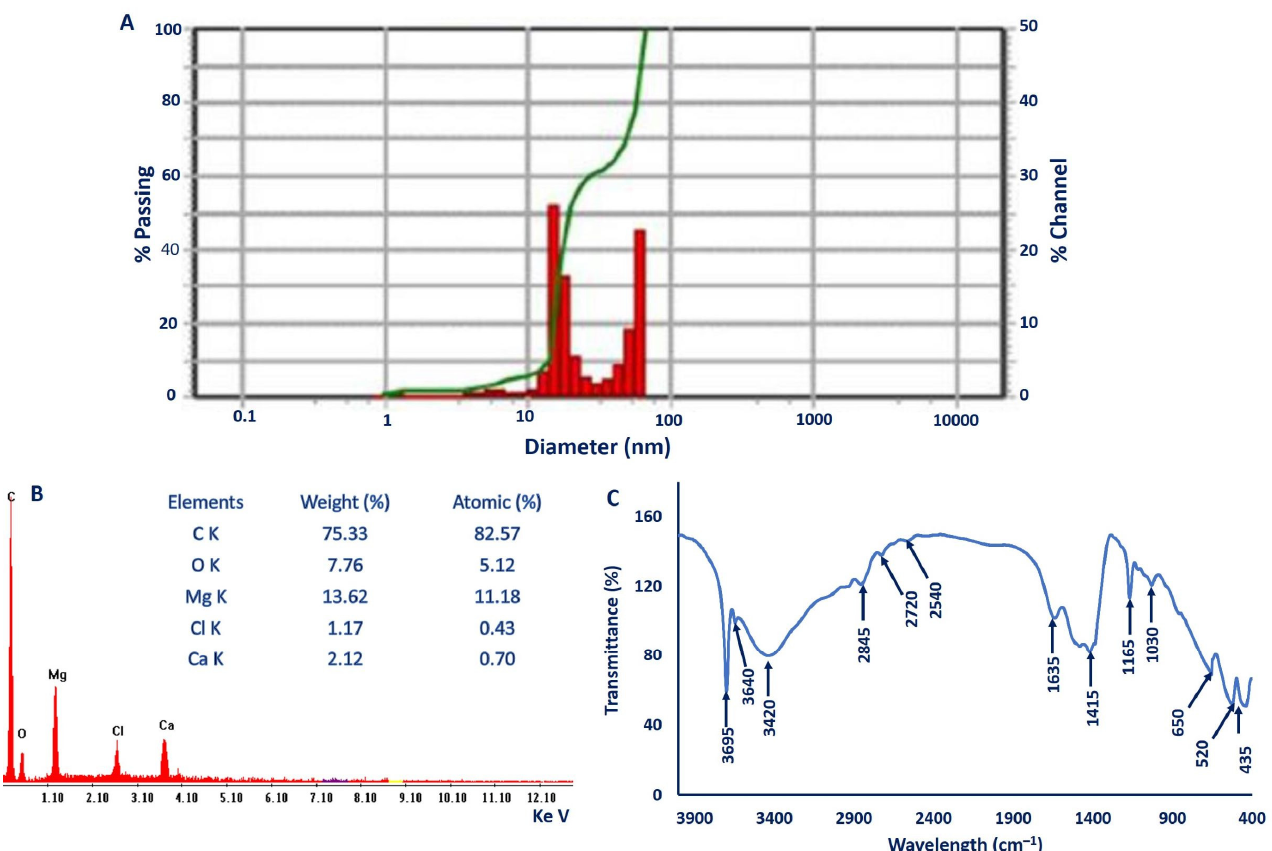
Figure 3. Characterization of biosynthesized MgO-NPs. ( A ) Dynamic light scattering (DLS) analysis, ( B ) energy dispersive X-ray (EDX) analysis, and ( C ) Fourier transform infrared (FT-IR) spectroscopy.